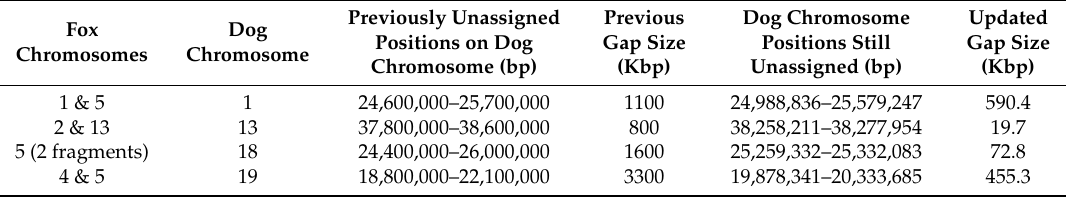
Table 1. Refinement of gaps in synteny between dog and fox. Four dog chromosomes map in more than one syntenic block to the fox genome, meaning a single dog chromosome is syntenic to more than one contiguous region of the fox as the result of either a fission event in the dog lineage or a fusion event in the fox lineage. The breakpoints and sizes of the unassigned regions as refined by previous analysis [44] are indicated in the third and fourth columns, respectively. High-resolution mapping in the present study allowed for refinement of the breakpoints, as indicated in the fifth and sixth columns. All genomic locations are based on CanFam3.1. RACA fragment 1a is excluded due to its lack of